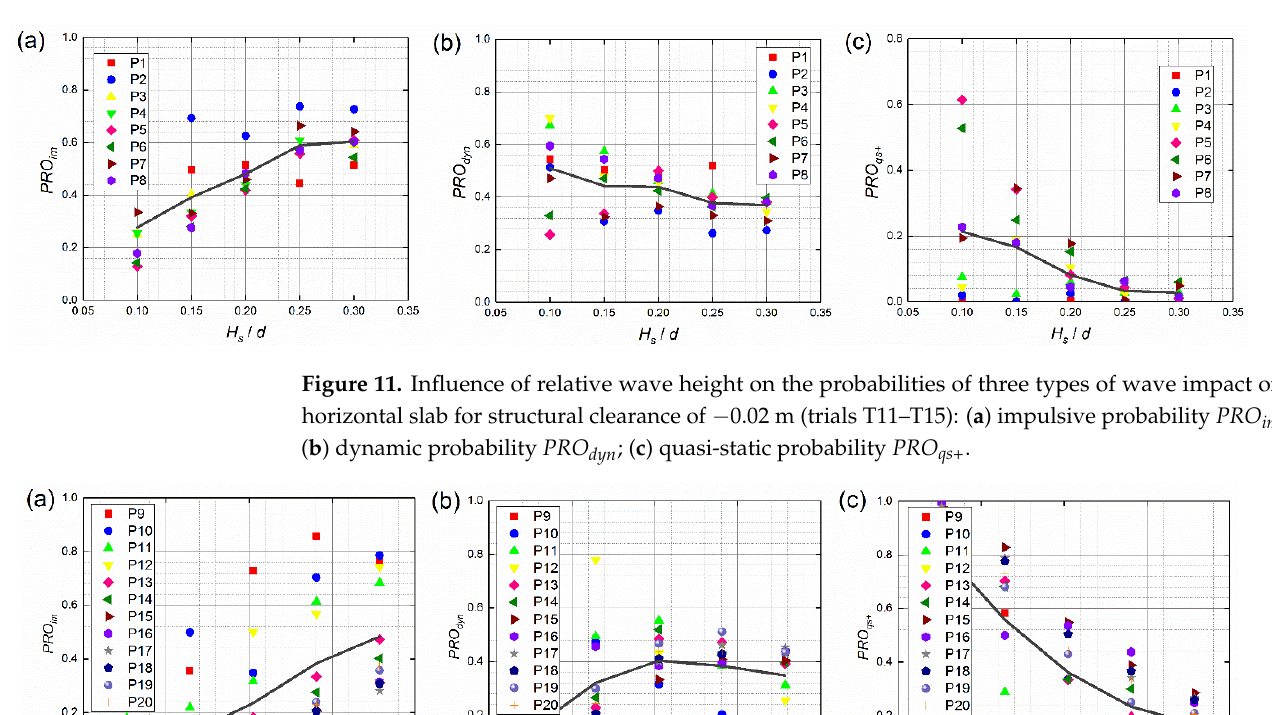
Figure 10. Influence of relative wave height on the probabilities of three types of wave impact on horizontal slab for structural clearance of 0.02 m (trials T21 – T25): ( a ) impulsive probability PRO im ; ( b ) dynamic probability PRO dyn ; ( c ) quasi-static probability PRO qs+ .